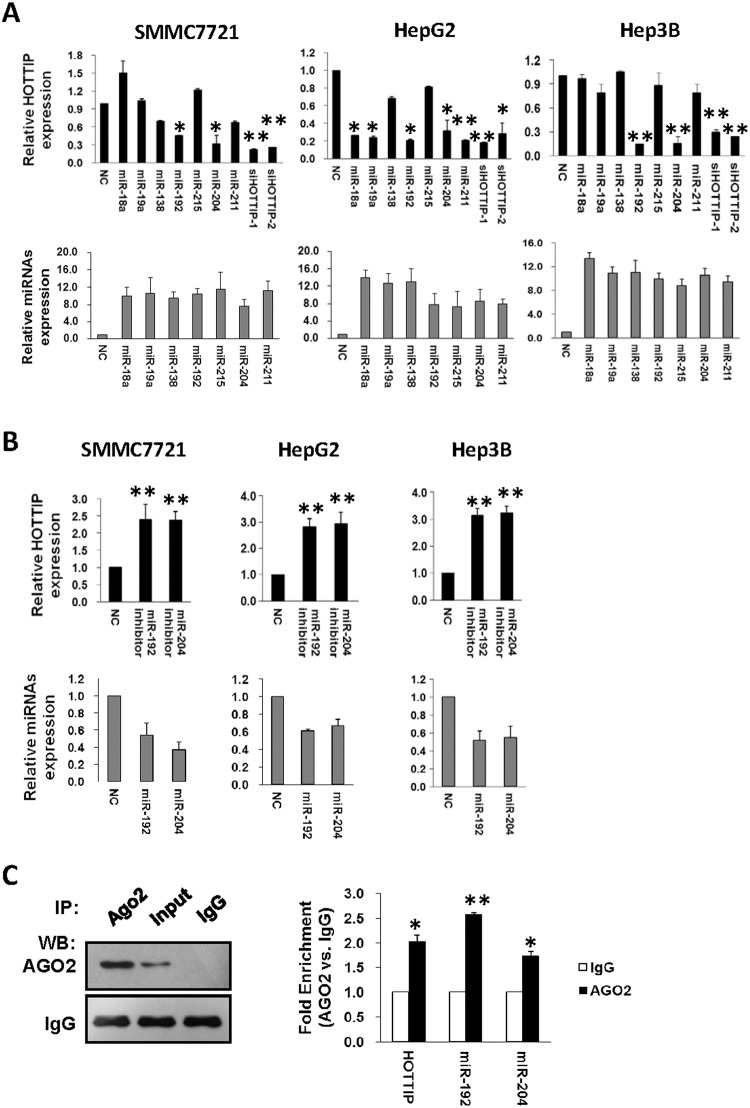
Identification of candidate miRNAs targeting lncRNA HOTTIP.(A) MiR-192 and miR-204 inhibit HOTTIP expression. 20 nmol/L mimics of miR-138, miR-18, miR-192, miR-215, miR-19, miR-204, and miR-211, two HOTTIP siRNAs (siHOTTIP-1 and siHOTTIP-2)or NC RNA were transfected into SMMC7721,HepG2 and Hep3B HCC cells. HOTTIP expression was detected at 48h after transfection (up, black columns). The transfection efficiency of different miRNAs was confirmed by qRT-PCR (low, grey columns). (B) Inhibition of miR-192 or miR-204 up-regulates HOTTIP expression. 20 nmol/L miR-192 inhibitors, miR-204 inhibitors and NC RNA were transfected into SMMC7721,HepG2 and Hep3BHCC cells. HOTTIP and miRNAs expression was detected at 48h after transfection (up, black columns). The transfection efficiency of different miRNAs was confirmed by qRT-PCR (low, grey columns). (C) Association of miR-192/-204 and HOTTIP with AGO2. HepG2 cellular lysates were used for RNA immunoprecipitation with AGO2 antibody. Detection of AGO2 and IgG using western blot (up), and detection of miR-192, miR-204 or HOTTIP using qRT-PCR (low). All data of HOTTIP expression were normalized to β-actin mRNA expression levels. All miRNA expression data were normalized to U6 small RNA expression. All results of the mean of triplicate assays with standard deviation are presented.*P< 0.05, **P< 0.01.